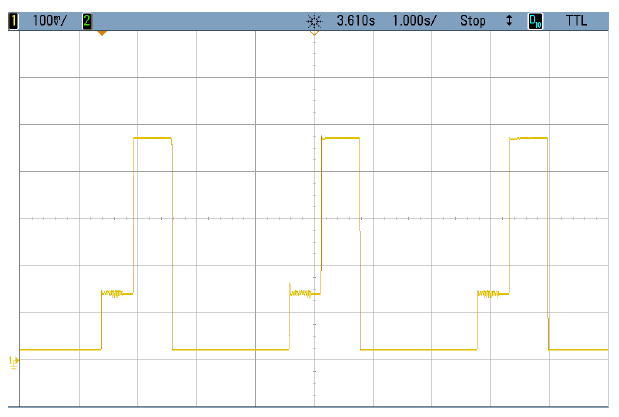
Figure 18. Detail (MD5, SW, 2000, COMP,